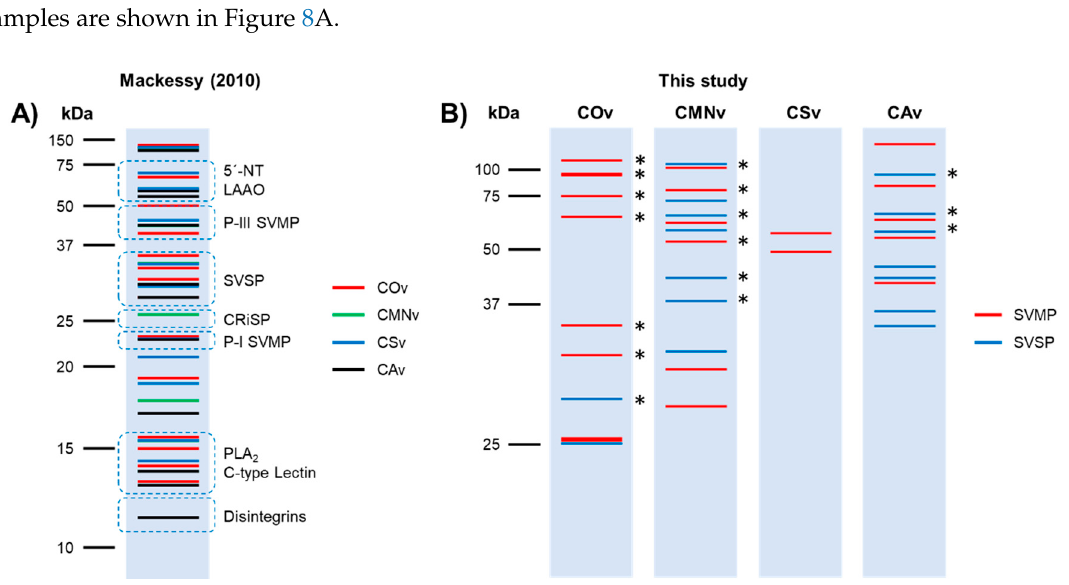
Figure 8. Schematic representation of SDS-PAGE and zymography bands observed in the venoms. ( A ) Summary of the bands observed in the SDS-PAGE for C. ornatus (COv, red line), C. m. nigrescens (CMNv, green line), C. scutulatus (CSv, blue line), and C. atrox (CAv, black line). Blue ovals enclose the typical molecular weight intervals for the most abundant toxin families according to Mackessy [53]. ( B ) Schematic representation of the SVMP (red line) and SVSP (blue lines) bands observed in zymographies for C. ornatus (COv), C. m. nigrescens (CMNv), C. scutulatus (CSv), and C. atrox (CAv). SVMP are represented in red lines and SVSP in blue lines. Asterisks denotes the proteolytic bands that have never been described in the literature.